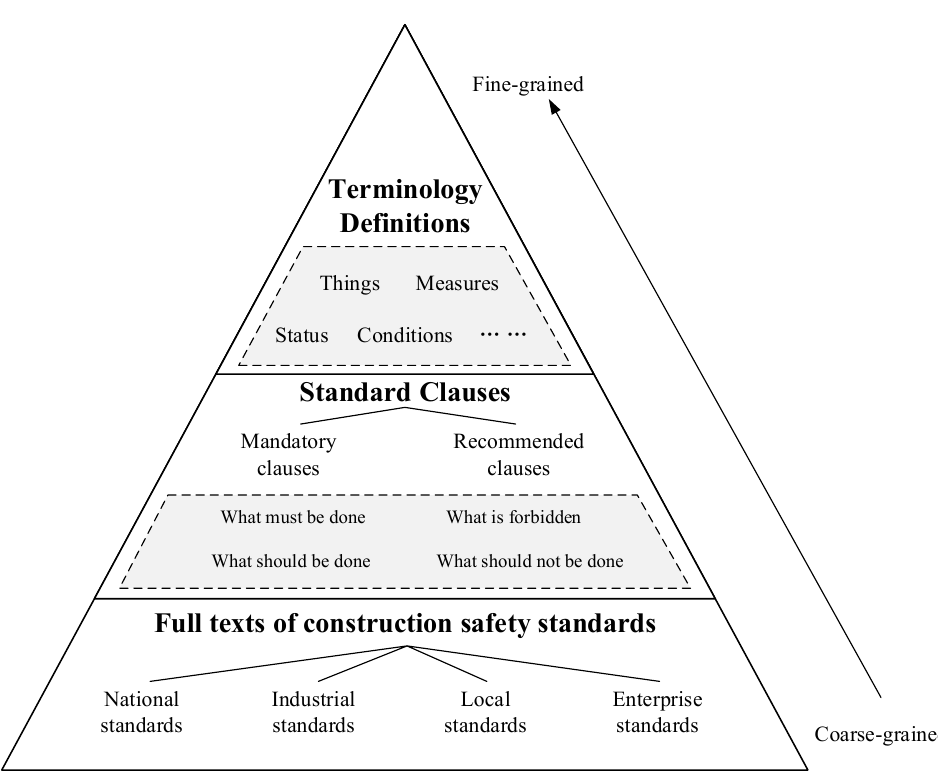
Figure 1. Structure analysis of construction safety standard knowledge.